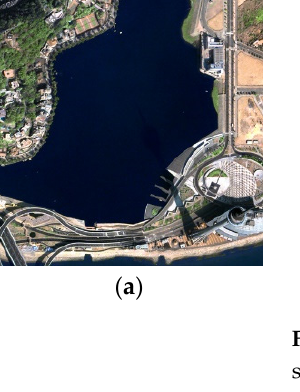
mentation result.